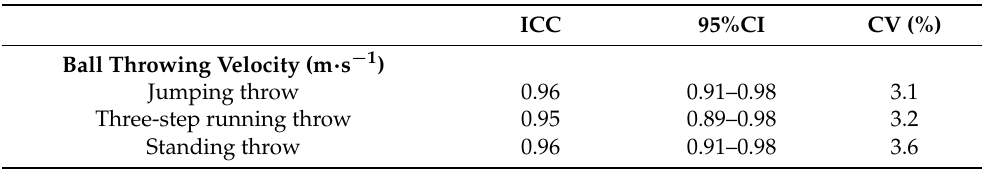
Table 2. Intraclass correlation coefficient and coefficient of variation showing acceptable reliability for measures of ball throwing